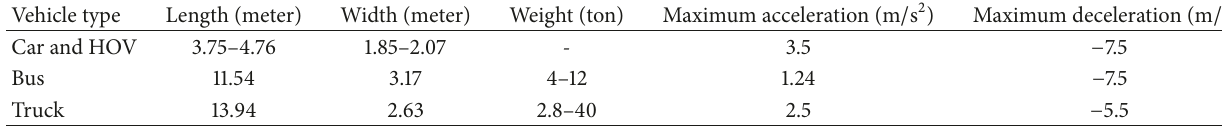
Table 3: Vehicles characteristics.